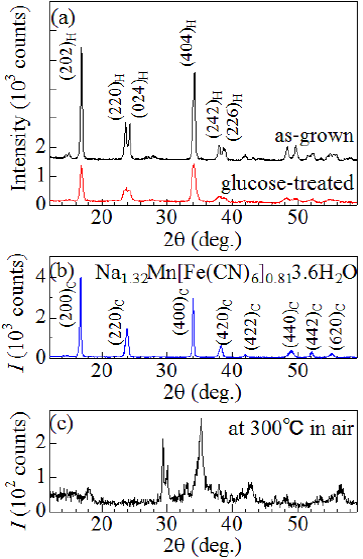
Figure 2. ( a ) XRD patterns of as-grown and glucose-treated Mn-PBAs. The subscripts, H, of the index represent the hexagonal setting; ( b ) XRD patterns of a prototypical PBA, Na Mn[Fe(CN) ] 3.6H O. The subscripts, C, of the index represent the face-centered 1 . 32 6 0 . 81 2 cubic setting; ( c ) XRD pattern of Mn-PBA after the heating in air at 300 ◦ C for 90